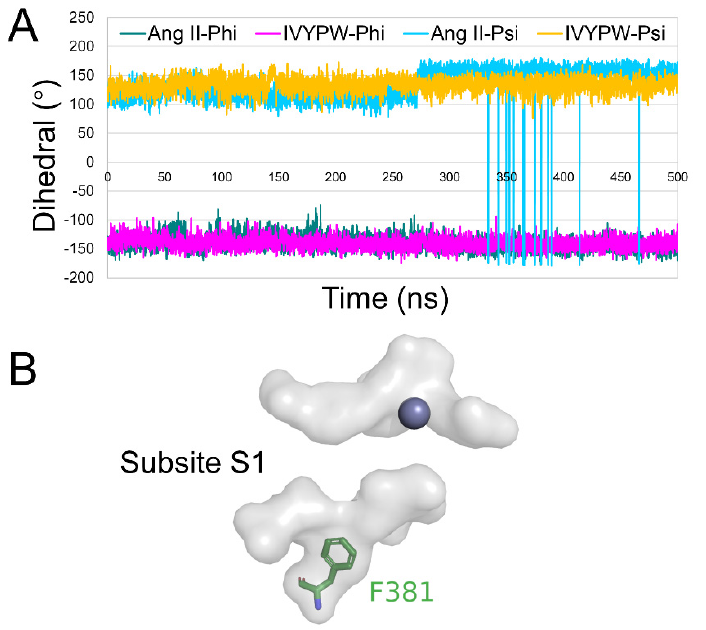
Figure 9. ( A ) Dihedral change of Phe381 in the hDPP III–Ang II and hDPP III–IVYPW complexes during 500 ns simulations. ( B ) A close view of subsite S1 (in the surface form) with Phe381 shown as green sticks and the Zn atom shown as a grey sphere.